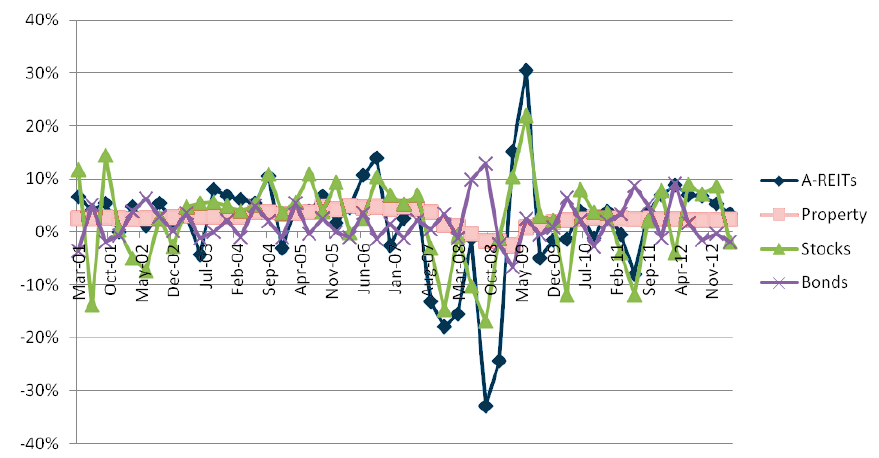
fig. 1. total returns of asset classes, quarterly returns, % (authors’ calculation based on data from IPD australia and DataStream) note: Property returns are smoothed